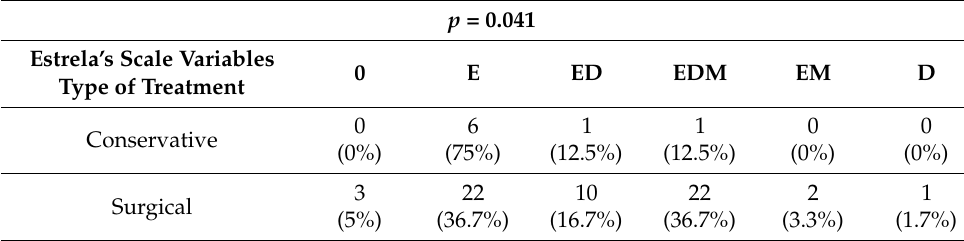
Table 2. Estrela scale variables (number and percentage) of periapical lesions and their correlation with the necessity of surgical intervention. Bone expansion–E, bone destruction–D, bone destruction towards the maxillary sinus–M or none–0 and their